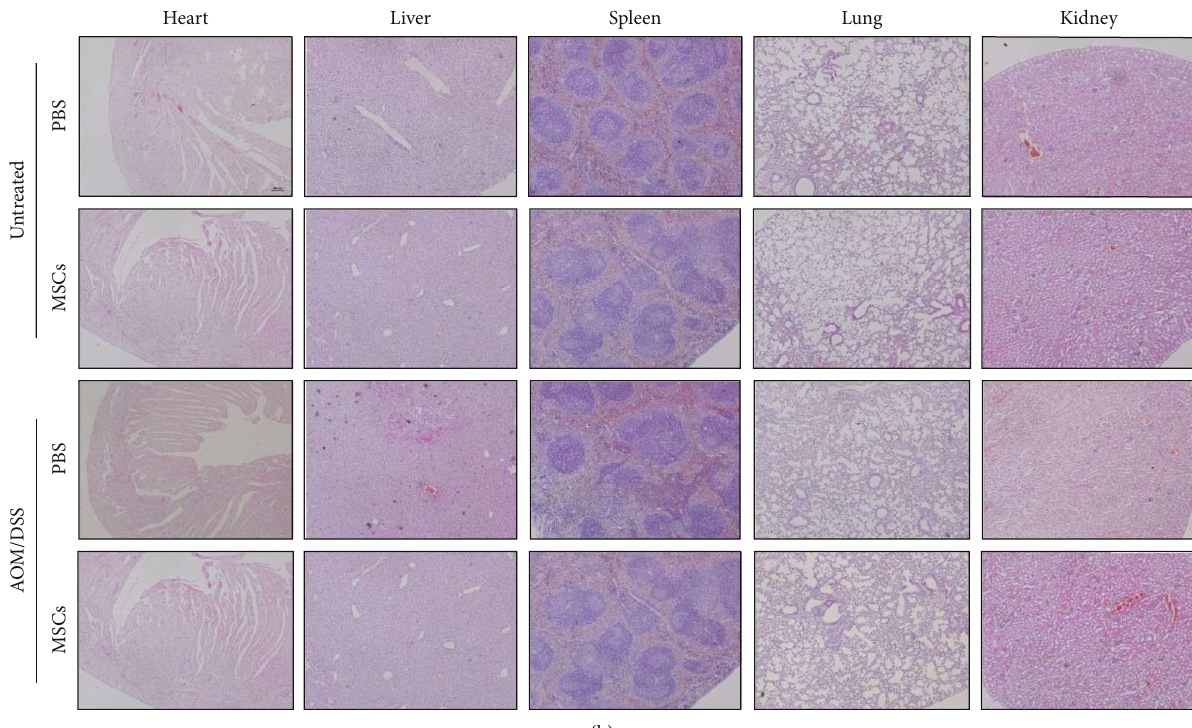
Figure 3: HUC-MSCs e ff ectively inhibit tumorigenesis. (a, b) The same amount of B16 cells ( 1 × 10 6 cells) was injected into the left side of PBS and HUC-MSC group nude mice; then, 1 × 10 6 HUC-MSCs were intravenously injected into the MSC group twice a week, and the same amount of PBS was injected into the PBS group to observe the occurrence of tumors ( n = 6 ). (c) HUC-MSC injection reduces colonic tumor burden in C57BL/6J mice induced by AOM/DSS ( n = 5 ). (d, e) Tumor numbers in the PBS and HUC-MSC group after treatment with AOM/DSS. (f) Hematoxylin-eosin (HE) staining of colons. Intravenous injection of HUC-MSCs promotes histological improvement. (g) Colon length in the PBS and HUC-MSC group after treatment with AOM/DSS. (h) Pathologic section of the colon, heart, liver, spleen, lung, and kidney in the PBS and HUC-MSC group treated with AOM/DSS. HUC-MSCs were intravenously injected once a week. No tumors were found in the heart, liver, spleen, lung, and kidney injected with or without